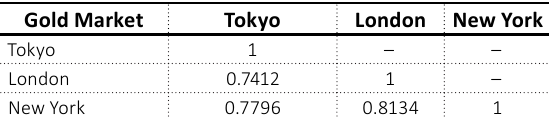
Table 5. DCC distributions of gold among